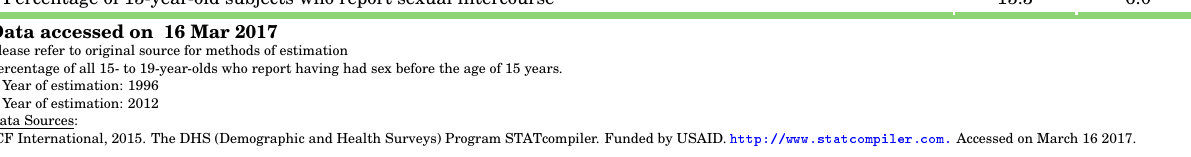
Table 41: Median age at first sex in Peru